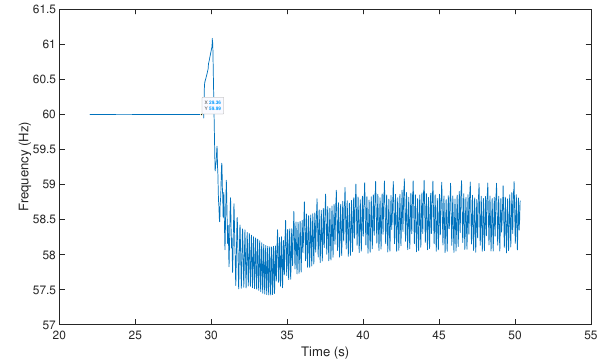
Figure 12. Frequency excursion after injection